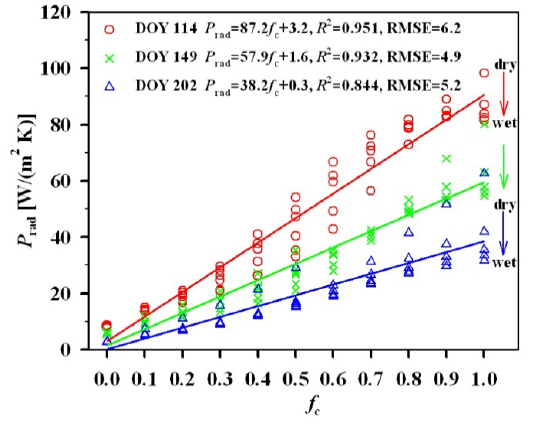
and f for three atmosphere conditions at the Yucheng rad c − T at 10:30 s a